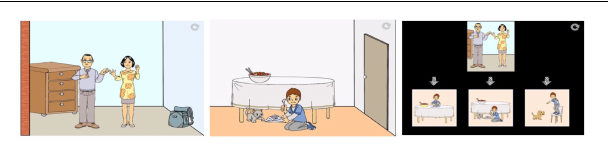
FIGURE 4 | Illustration of the complements